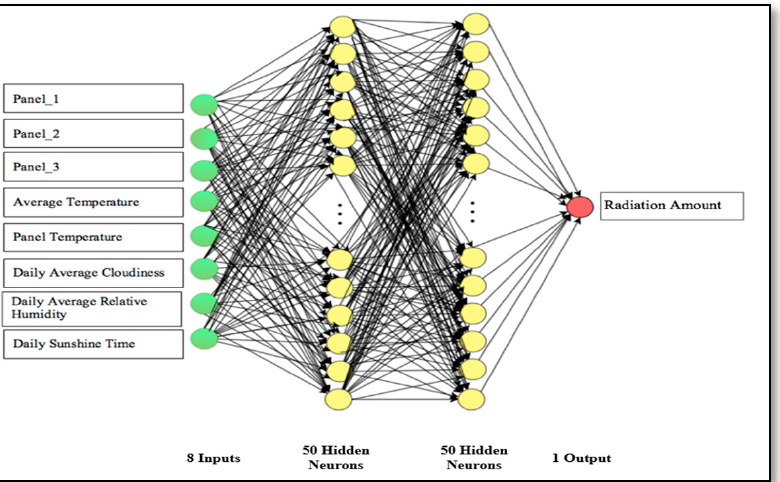
Figure 6. ANN model.